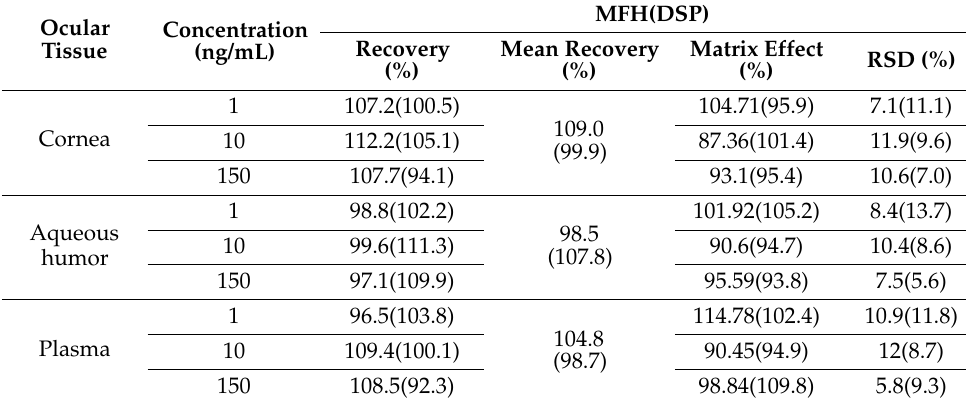
Table 3. Recovery data for MFH and DSP by